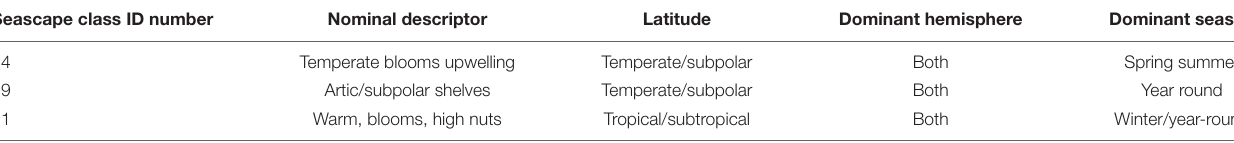
TABLE 2 | Seascapes classes present in the study region during the period January 2016–May